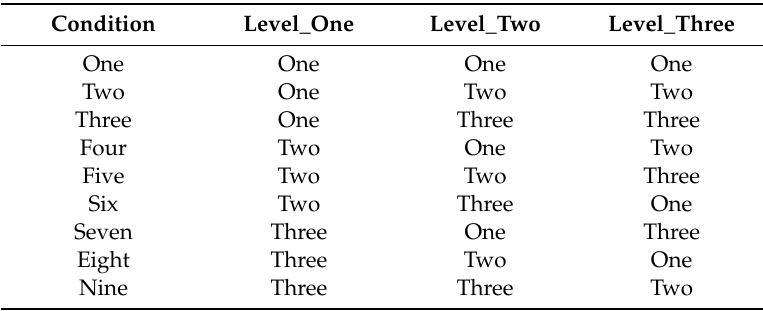
Table 2. Three level considerations Orthogonal Array for